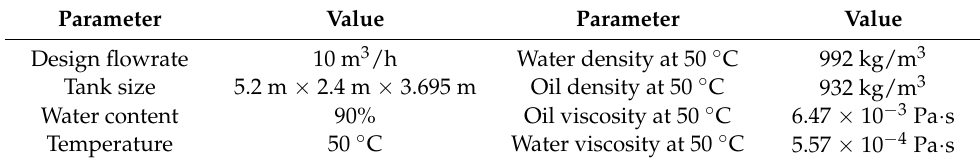
( b ) Figure 5. ( a ) Theoretical model diagram of coalescent packing assembly; ( b ) the actual appearance of coalescent packing assembly. In the laminar flow state, the droplet settling velocity ( v ) satisfied Equation (2). There- fore, the settling velocity of droplets with particle size 1.5 × 10 − 4 m and 1×10 − 4 m were 1.47 × 10 − 4 m/s and 6.52 × 10 − 5 m/s, respectively. The time required for settling and the length of the tank corresponding to the settling time were calculated according to